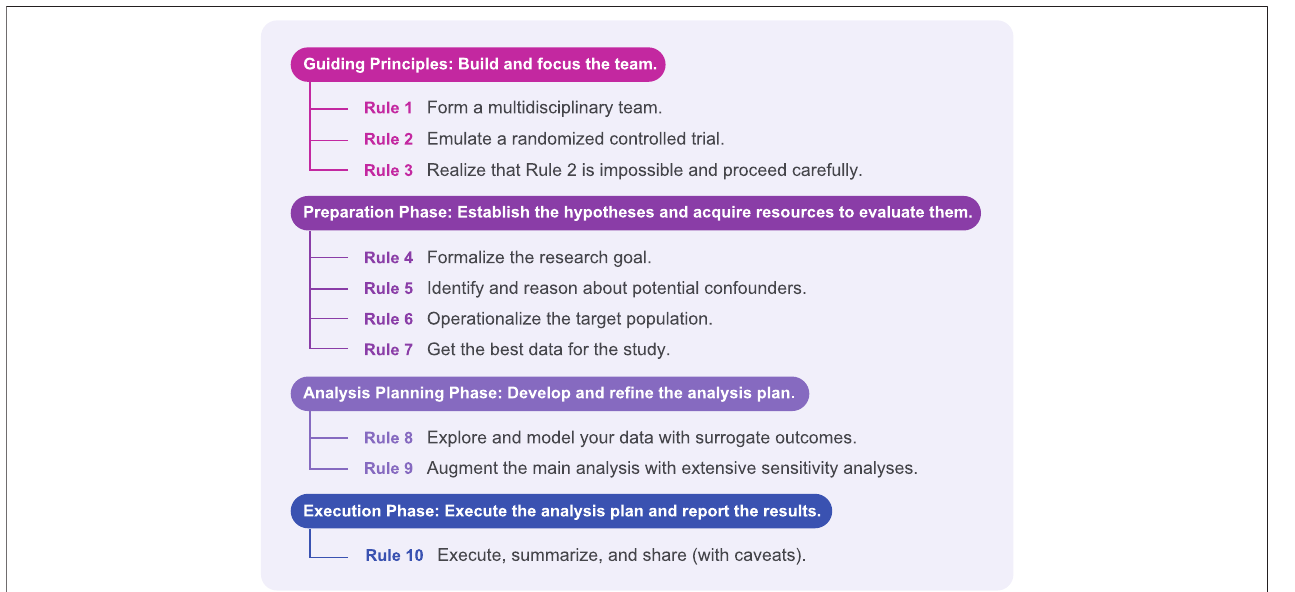
FIGURE1| The fi rstphaseofthe10rulesinvolvesbuildingtherightteamtoenvisiontheperfecttrialandthenconsiderthelimitationsofanobservationalstudy.The study then enters a preparation phase in which the details of the study are speci fi ed: hypotheses, which population to target, essential confounders to observe, and whichdata sets might support the study criteria. Inthe analysis planning phase, theobjective istore fi neand validate the studyde fi nitionsand selected methods without being in fl uenced by real results. Finally, the study concludes when the study is run, carefully summarized, and reported accurately.